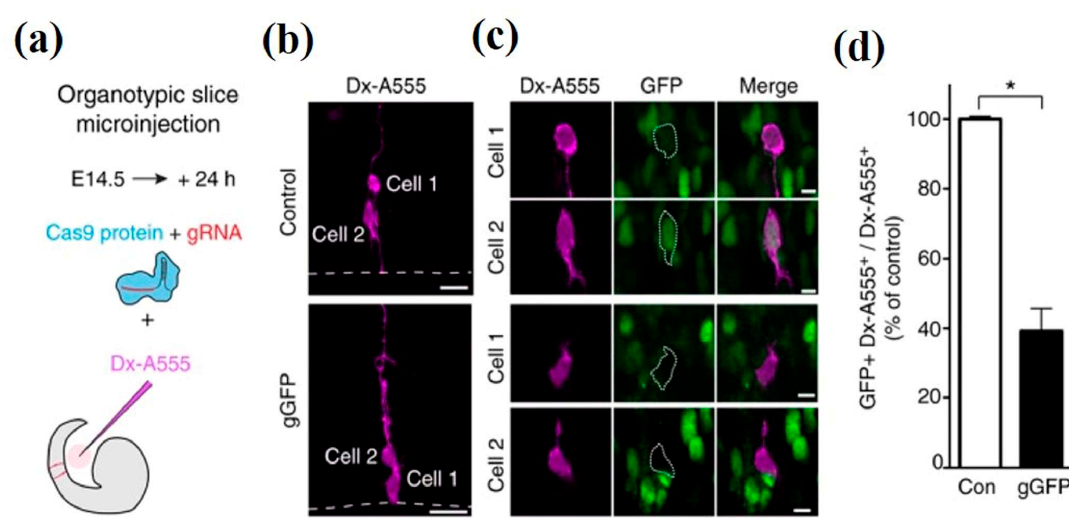
Figure 10. CRISPR/Cas9 (Clustered regularly interspaced short palindromic repeats- associated protein 9) -induced disruption of green fluorescence protein (GFP) expression in the daughter cells of single microinjected aRGCs in organotypic slices of the telencephalon of Tis21::GFP mouse embryos. ( a ) Scheme of the Cas9/gRNA complex microinjection. ( b ) Reconstruction of optical sections with maximum intensity projections for daughter cells of single aRGCs microinjected with either Cas9/control gRNA (top) or Cas9/gGFP (bottom) revealed by Dx-A555 immunofluorescence (magenta); cell 1, aRGC daughter; cell 2, BP daughter. Dashed lines depict ventricular surface. Scale bars, 20 μ m. ( c ) Single optical sections of cells 1 and 2 shown in ( b ), showing the effects of Cas9 and control gRNA (top) or gGFP (bottom) on GFP expression. Scale bars, 5 μ m. ( d ) Quantification of the proportion of daughter cells (Dx-A555 + ) of microinjected cells showing GFP expression 24 h after control (Con, white) or gGFP (black) microinjection. (* p < 0.05, Fisher’s test) Reprinted with the permission of [147].